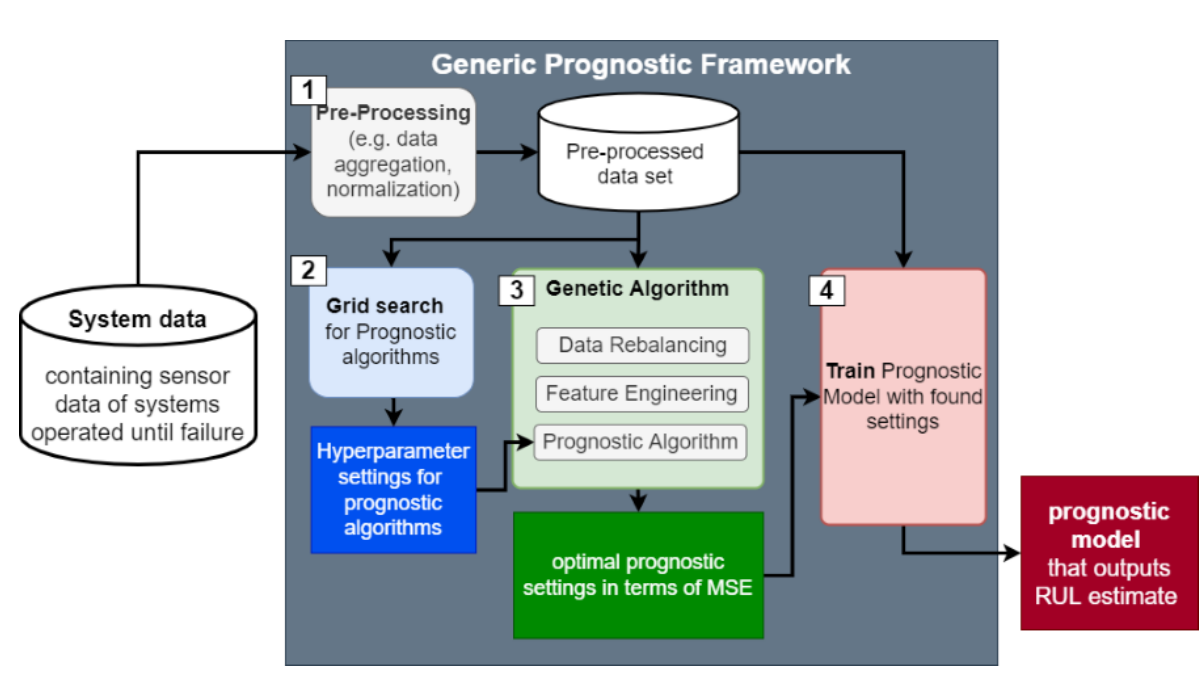
Figure 1. The elements of the generic prognostic